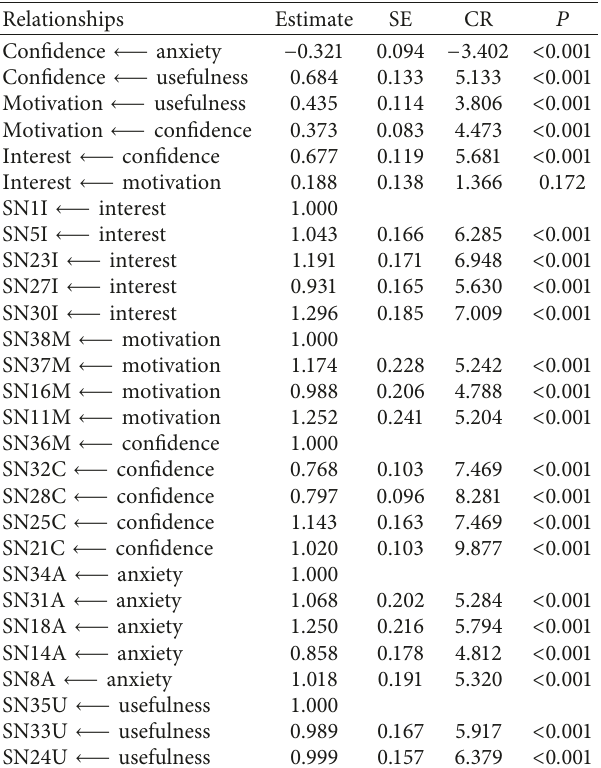
Table 8: Standardized regression weights.